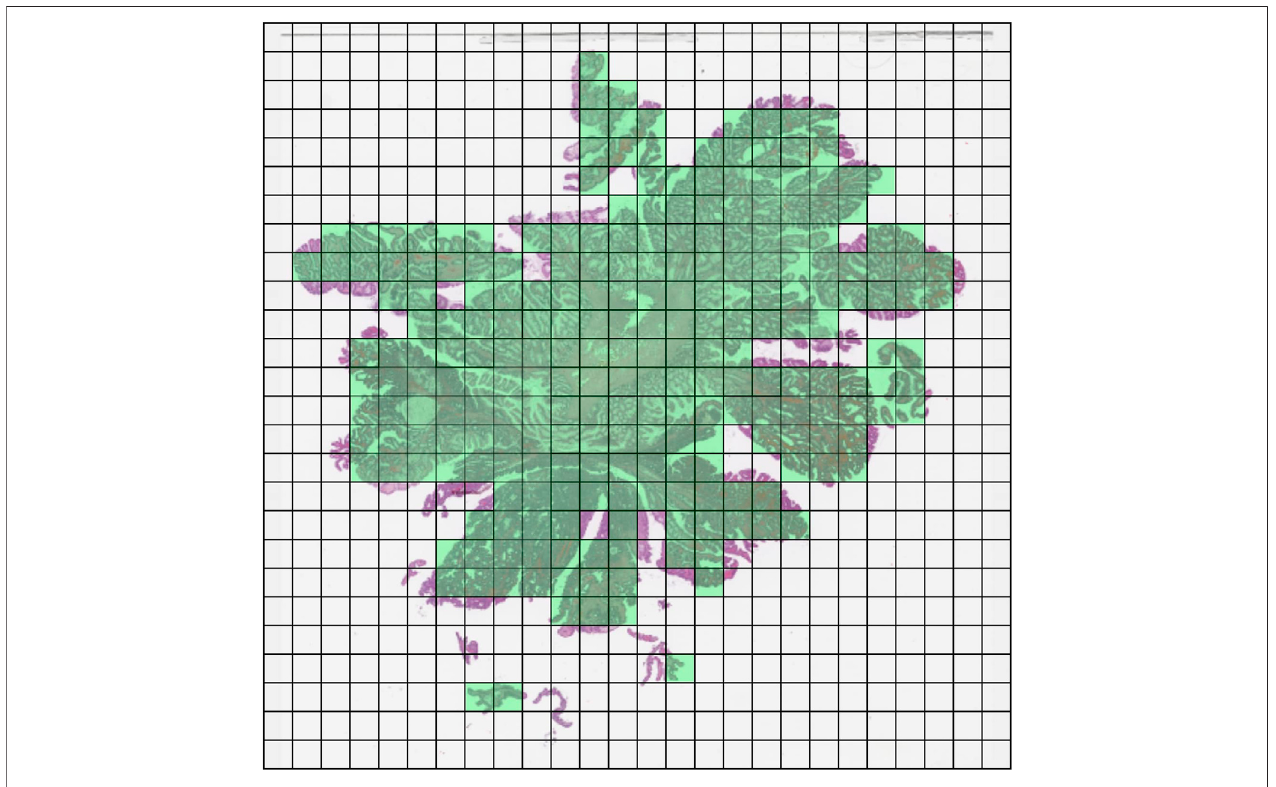
FIGURE 3 | An example of the grid extraction method. The patches in green are selected since they contain enough tissue.